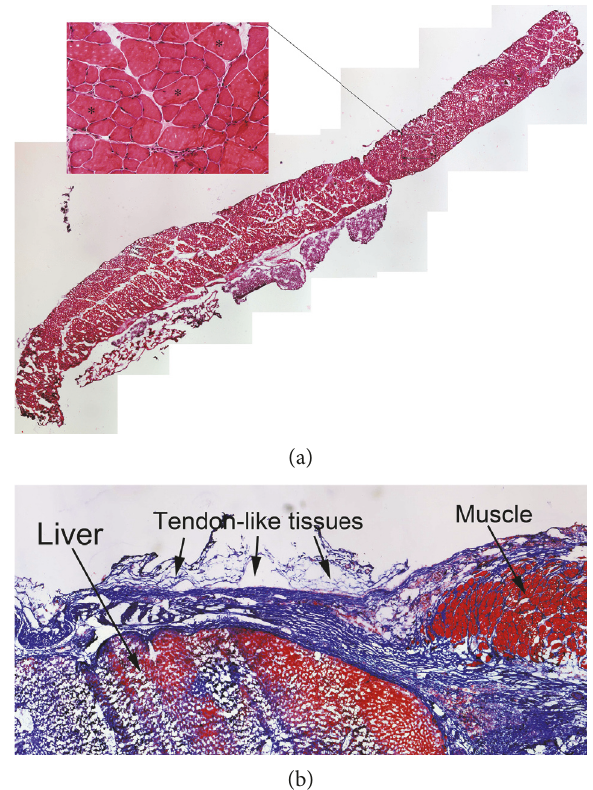
Figure 8: H&E staining to identify the muscular-tendon regrowth in the rat diaphragmatic defect. (a) Regenerated muscle tissue within the ECM sca ff old after repairing diaphragmatic defect four months later. (b) Tendon-like tissue (arrows, blue tissue) can be detected connecting new muscle tissue within the repaired rat diaphragm. ∗ indicates central nuclei of regenerative muscle fi bers; arrows indicates tendon-like